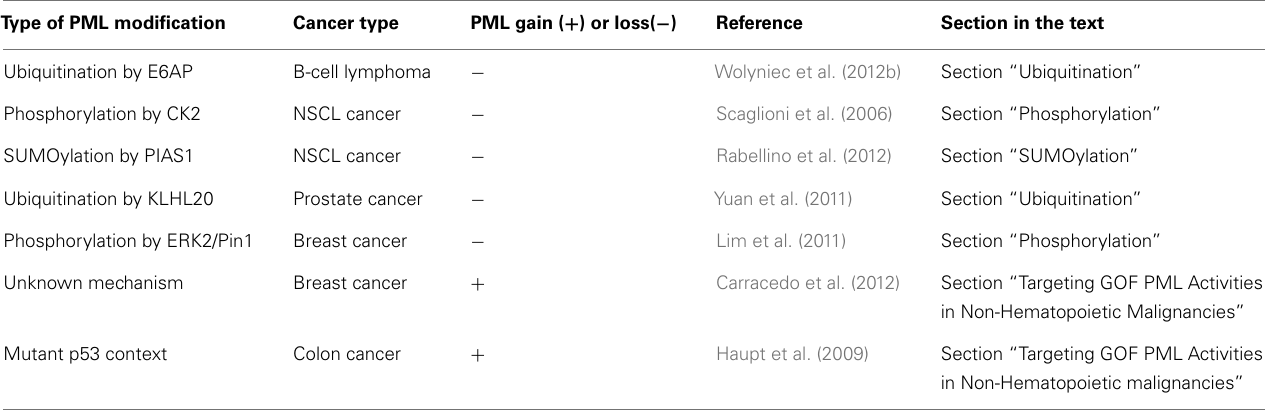
Table 1 | Summary of PML modifications implicated in various human